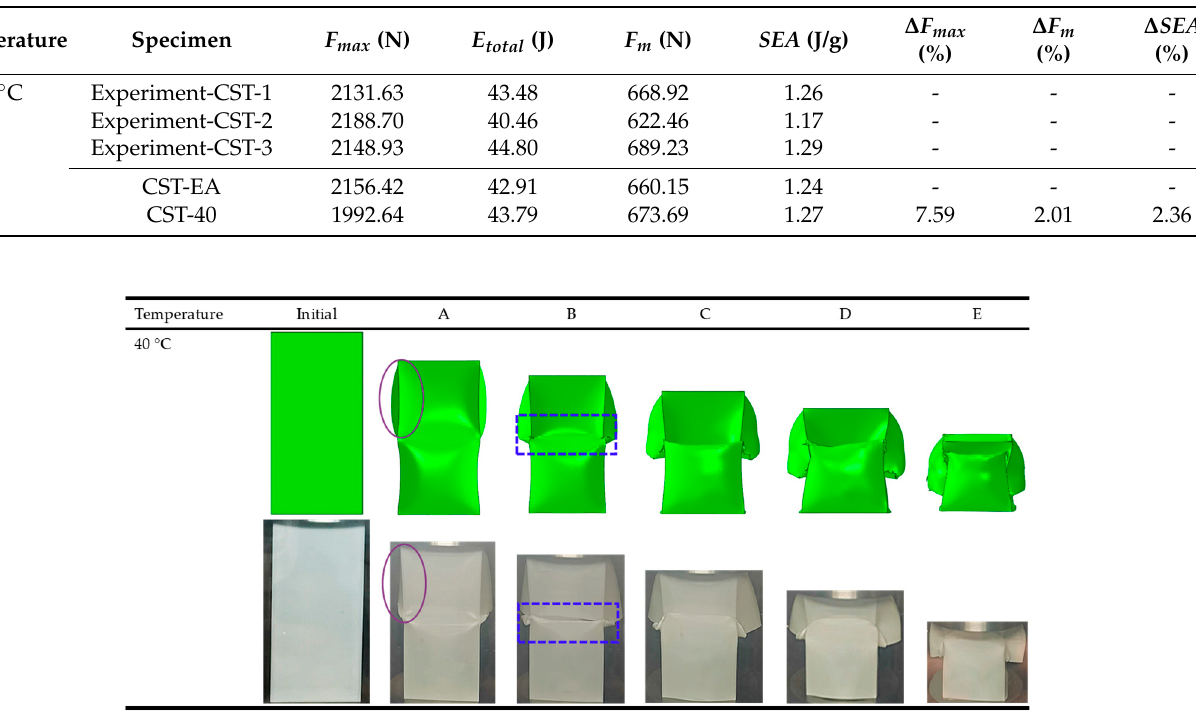
Figure 6. Comparison of experimental and simulated force-displacement curves for CST at 40 ◦ C. Table 2. At 40 ◦ C, the experimental and simulated comparison results of various energy absorption indicators of CST. (EA is the average of the three experiments).